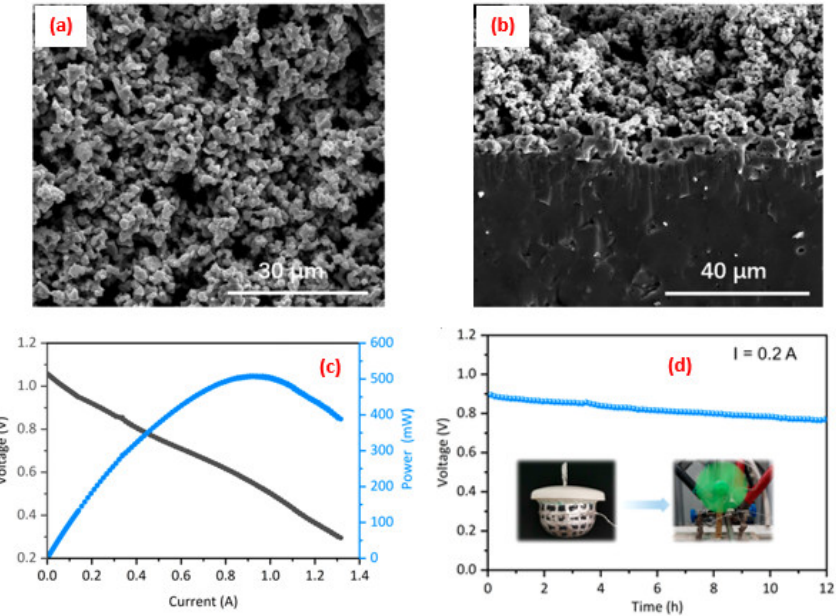
Figure 5. Microstructure of the ( a ) anode; ( b ) the cross-sectional image of the single cell; ( c ) current- voltage-power curve of the bowl-shaped hybrid direct carbon fuel cells and; ( d ) time-dependent voltage measured at a current of 0.2 A at 800 °C. Copyright 2020 by the American Chemical Society [76].